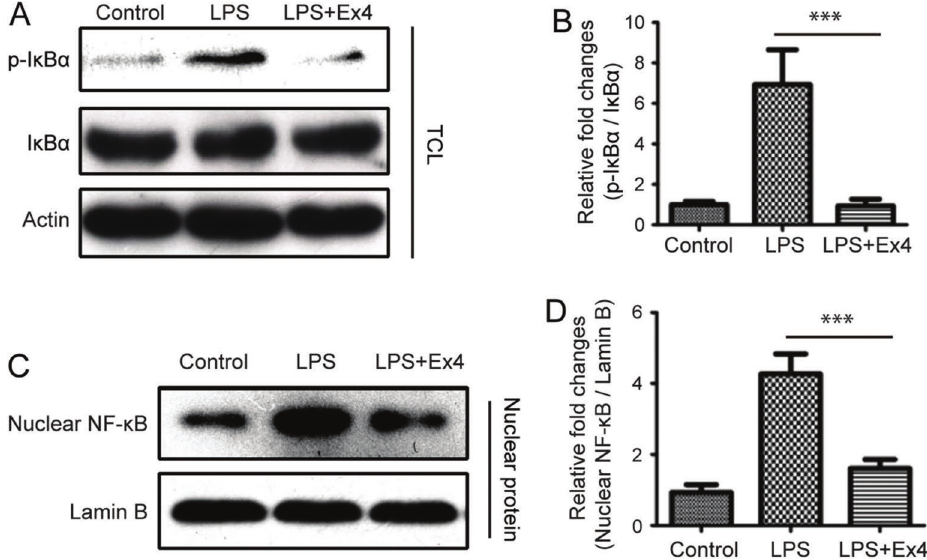
Figure 5. Effect of exendin-4 (Ex4) on lipopolysaccharide (LPS)-activated NF- k B pathway in RAW264 macrophages. RAW264 cells were treated with LPS or a combination of LPS and Ex4 for 30 min. Western blot image ( A ) and quanti fi cation ( B ) of basal protein and phosphorylation levels of I k B a . Western blot image ( C) and quanti fi cation ( D ) of NF- k B protein level in nuclei. TCL: total cell lysate. The results are representative of three independent experiments. Data are reported as means ± SD. ***P o 0.001